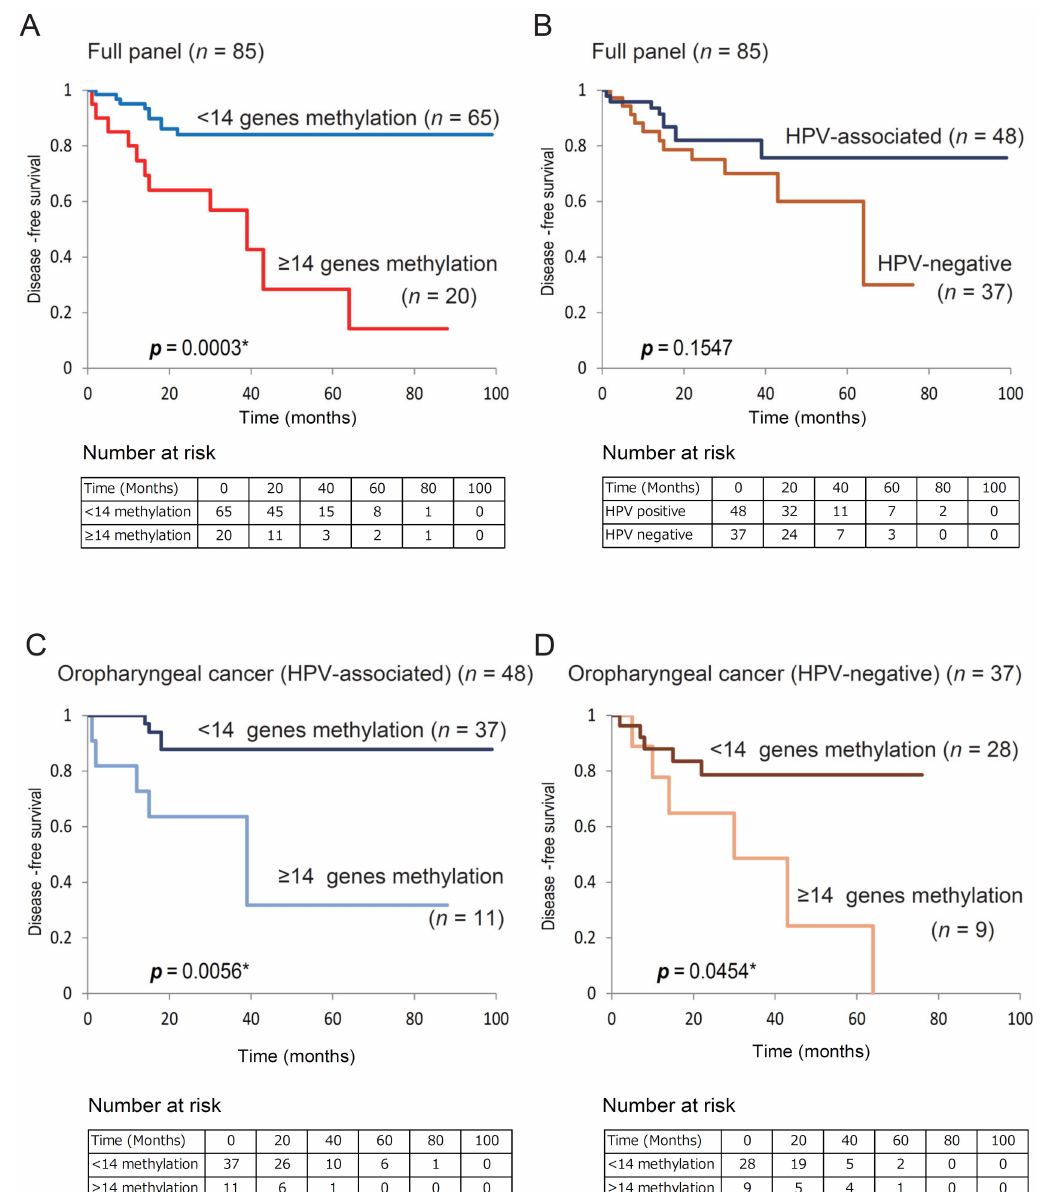
Figure 3. Kaplan–Meier survival curves for patients with OPC based on GPCR gene methylation status. Disease-free survival based on ( A ) methylation status in full cases ( n = 85), ( B ) HPV status in full cases ( n = 85), ( C ) methylation status in HPV-associated OPC cases ( n = 48), ( D ) methylation status in HPV-negative OPC cases ( n = 37). * p <